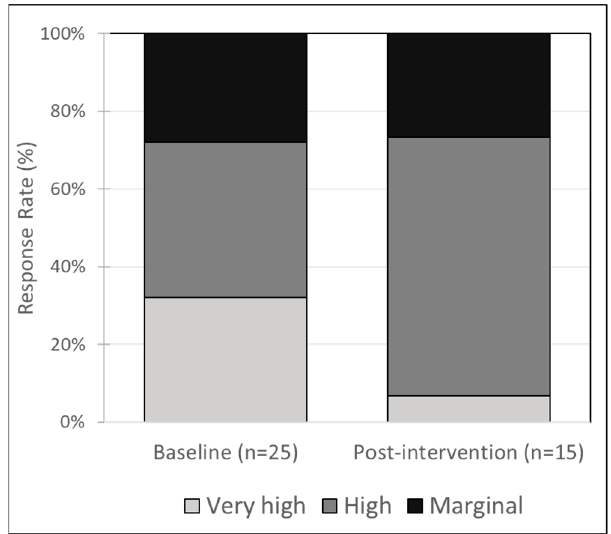
Figure 1. Distribution of food insecurity category at baseline and post-intervention (chi-square test p =